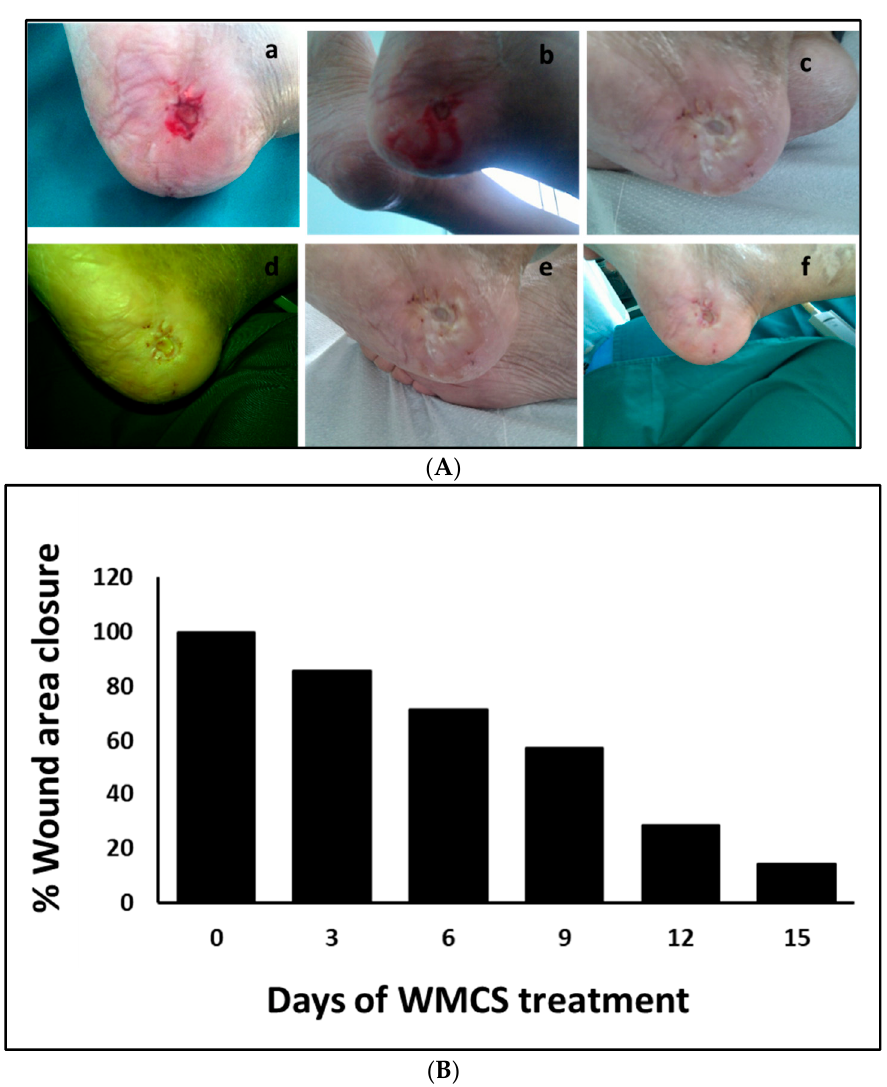
Figure 2. ( A ) (a–f): Serial photography of the clinical outcome of Patient 2 after WMCS treatment. ( B ) Presentation of the photographic wound closure percentage of Patient 2. Wound healing is expressed as percentage wound area closure relative to original size [(wound area)/(original wound area)].